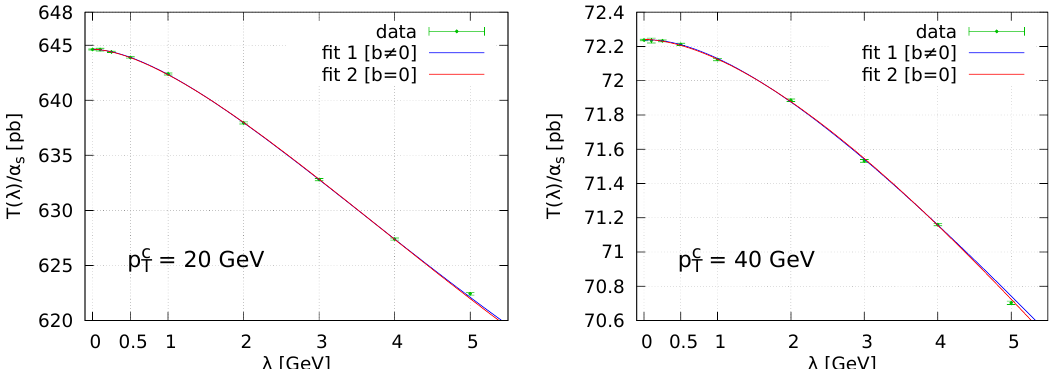
Figure 9 . T ( λ ) (defined in eq. (2.16)) as a function of the gluon mass λ for the total Z production cross section with the cut p , with p c = 20 GeV (left) and p c = 40 GeV (right). The green > p c T , Z T T T points are the results of our computations for several values of λ . The fit 1 and 2 lines are obtained with the fit function in eq. (4.2), where in fit 1 all parameters are fitted, while in fit 2 the coefficient of the linear term b is set to zero. The point corresponding to λ = 5 GeV has not been included in the